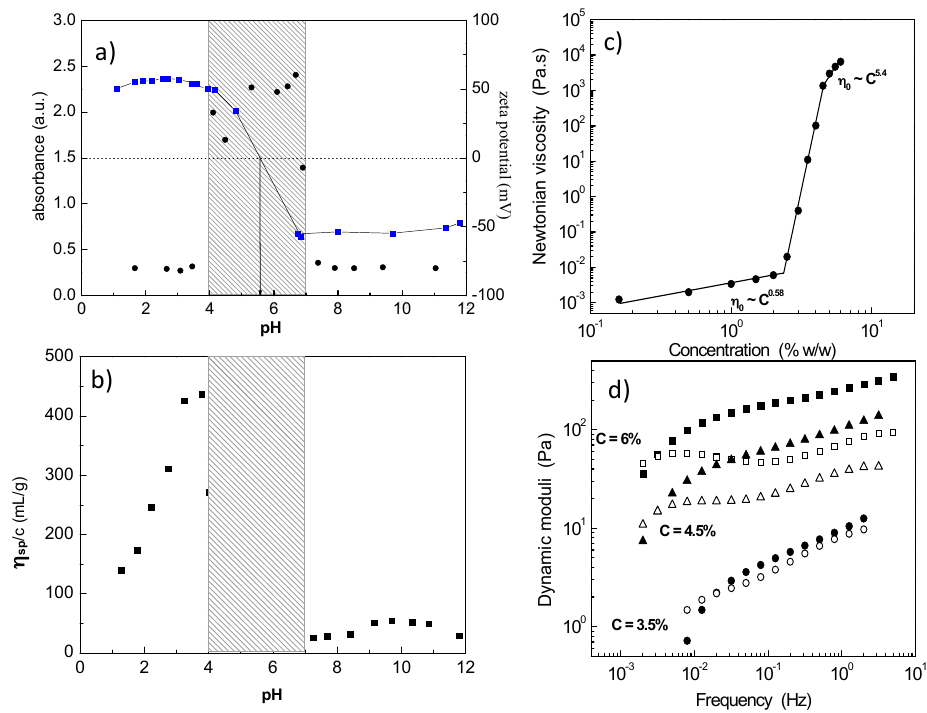
Figure 1. pH dependence of: ( a ) the optical absorbance (black symbols), the zeta potential (blue symbols); and ( b ) of the reduced viscosity, η sp / c , for a APA 1 aqueous solution (0.2 wt %) at 25 °C. ( a,b ) Adapted with permission from [32]. Copyright 2003 American Chemical Society. ( c ) Zero-shear viscosity as a function of polymer concentration. ( d ) Storage modulus G ′ (closed symbols) and loss modulus G ″ (open symbols) as a function of frequency at different polymer concentrations: circles (3.5 wt %), triangles (4.5 wt %), squares (6.0 wt %). Adapted with permission from [33]. Copyright 2004 American Chemical Society.